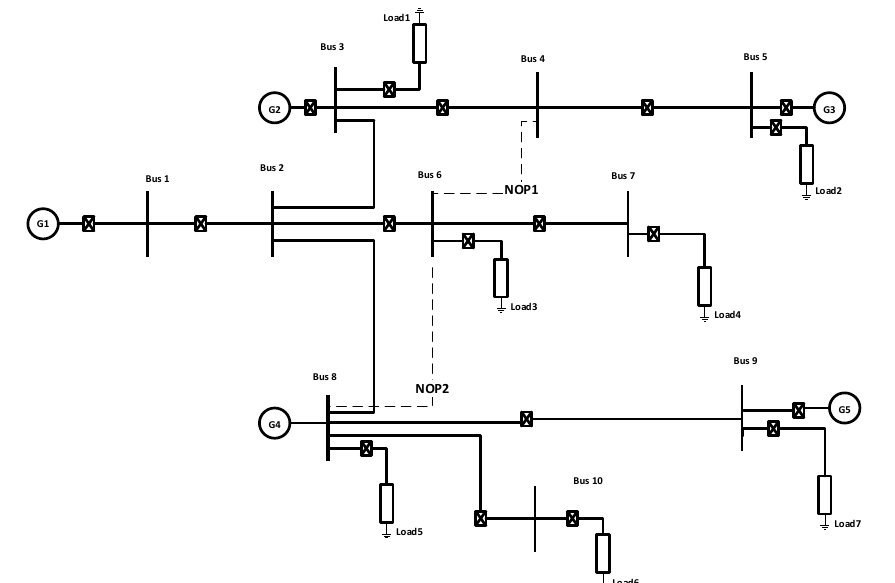
Figure 15. DC version of the CERTS microgrid.